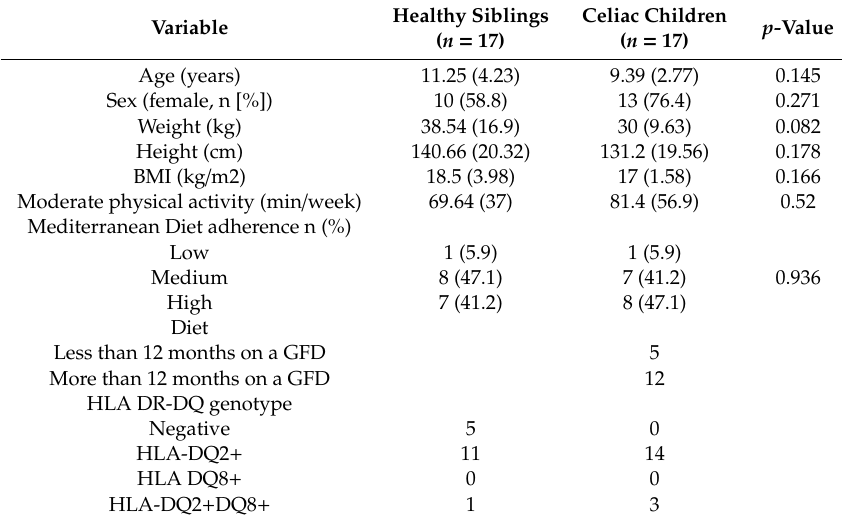
Table 2. Sociodemographic characteristics of the study participants.